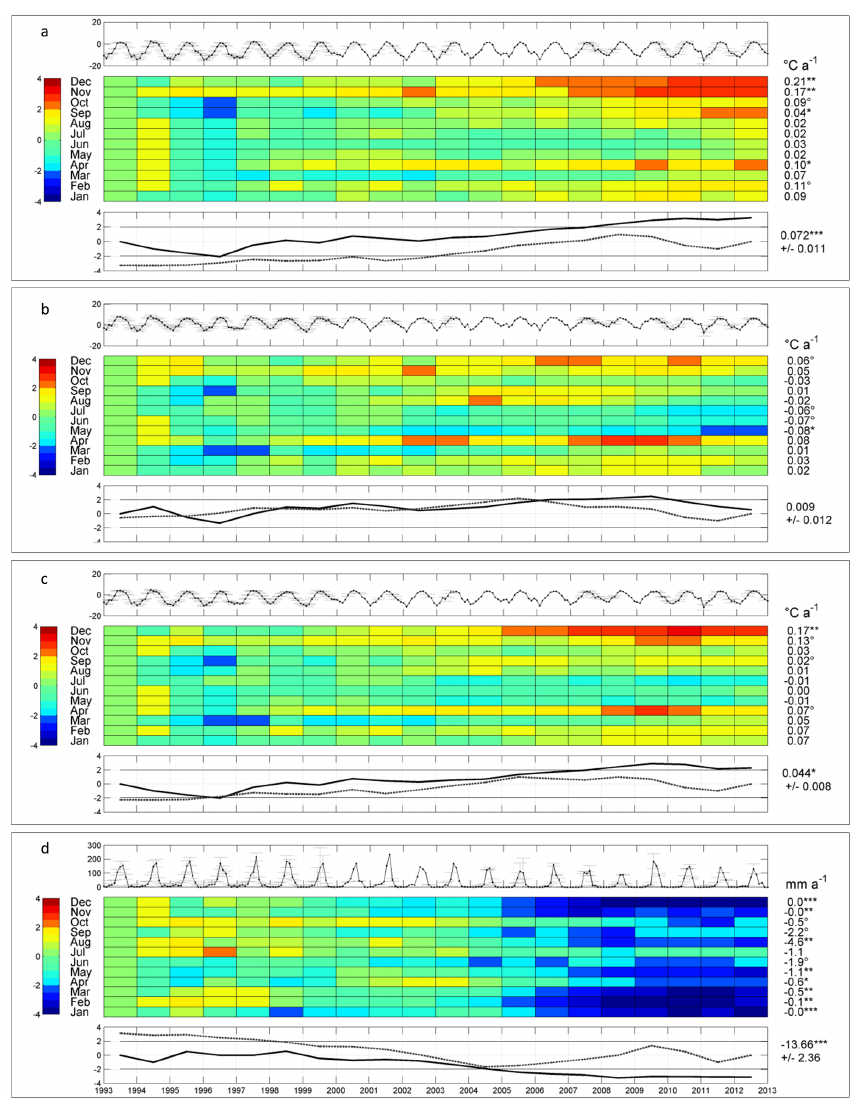
Figure 4. Trend analysis for (a) minimum, (b) maximum, and (c) mean air temperatures and (d) total precipitation in the upper DK Basin. The top graph of each meteorological variable shows the monthly trend (dark line) and uncertainty due to the reconstruction process (grey bars). The central grid displays the results of the sequential Mann–Kendall (seqMK) test applied at the monthly level. On the left, the colour bar represents the normalized Kendall’s tau coefficient µ ( τ ). The colour tones below − 1.96 and above 1.96 are significant ( α = 5%). On the right, the monthly Sen’s slopes and the relevant significance levels for the 1994–2013 period ( ◦ p -value = 0.1, * p -value = 0.05, ** p -value = 0.01, and *** p -value = 0.001). The bottom graph plots the progressive (black line) and retrograde (dotted line) µ ( τ ) applied on the annual scale. On the right, the annual Sen’s slope is shown for the 1994–2013 period. MATLAB ® script is available at http://www.irsa.